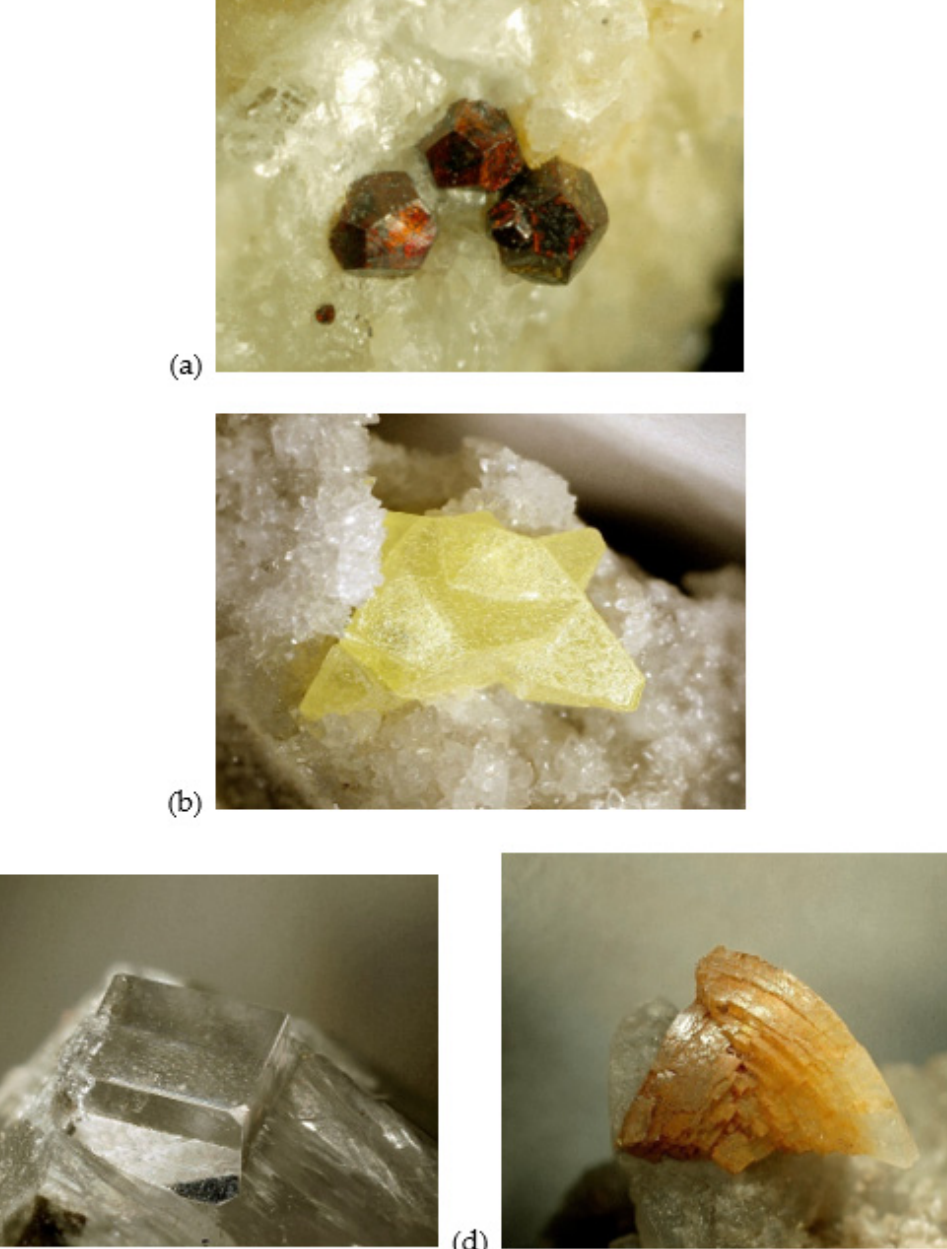
Figure 4. Minerals from the Burano Formation: ( a ) pyrite from Mt. Rosso (0.6 mm length); ( b ) sulfur from Rio Biola (Reggio Emilia, Italy), 5.3 mm; ( c ) fluorite from Sassalbo (Massa province), 2.1 mm; and ( d ) dolomite from Rio Canalaccio, Reggio Emilia, 3.9 mm. Photos by Enrico Bonacina.